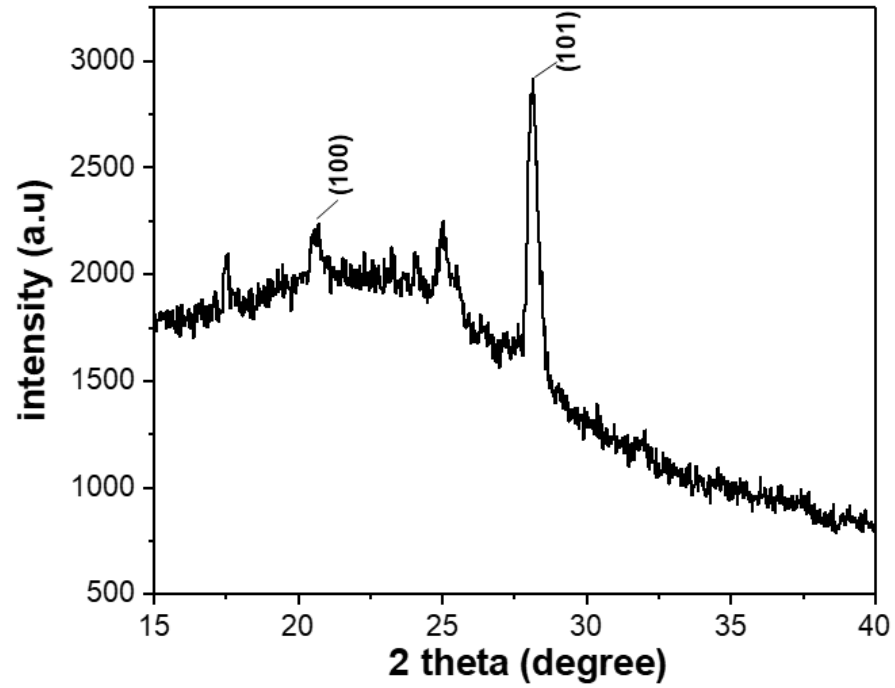
Figure 6. XRD pattern of the Se NPs prepared with the Se 4+ /CO volume ratio of 1/2.